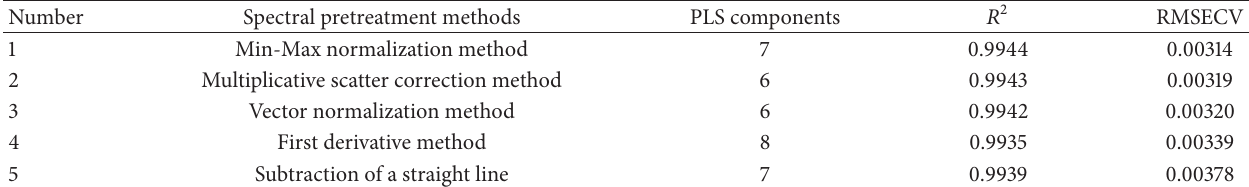
Table 3: Model verification results by using different spectral pretreatment methods.